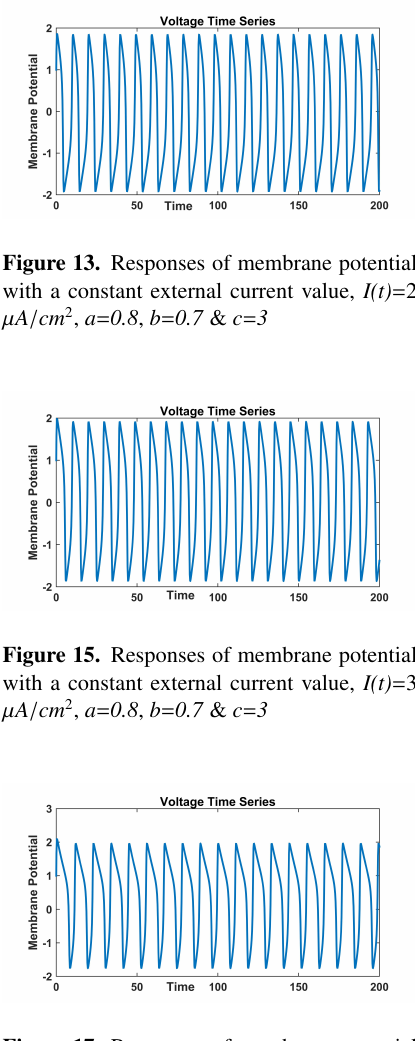
Neurons go to resting-state after some perturbation in the case of I(t) = 1 µ A / cm 2 (Fig.